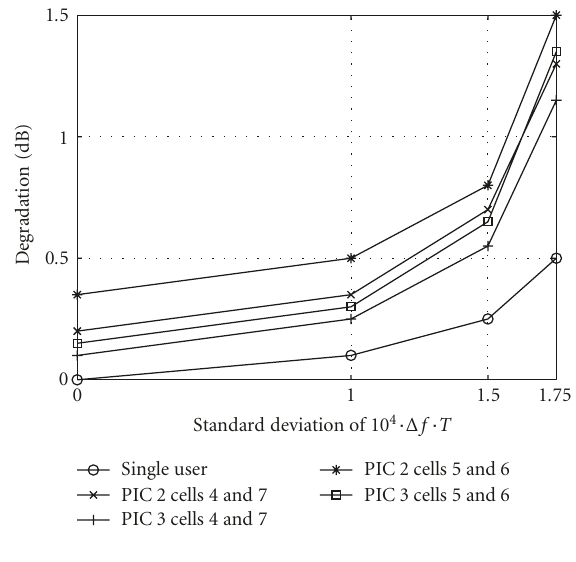
Figure 5: Degradation with frequency o ff sets.